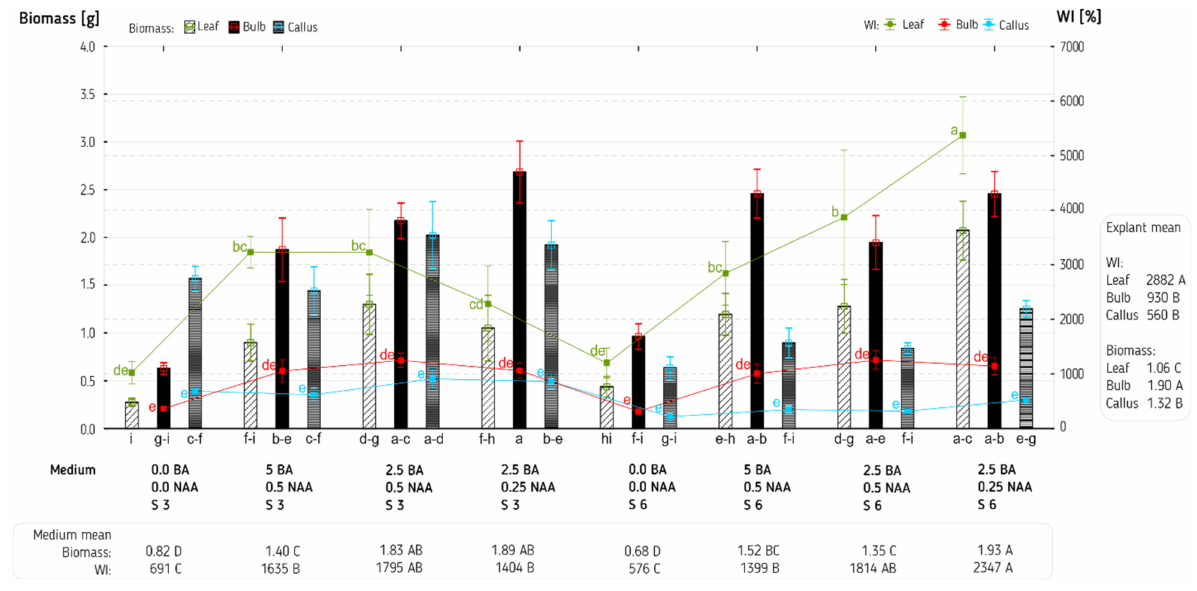
Figure 3. The effect of different explant and medium type on the biomass and biomass weight increase indicator (WI). Mean values ± SE with different small letters as well as mean values with different large letters are significantly different according to Duncan’s multiple range test at p ≤